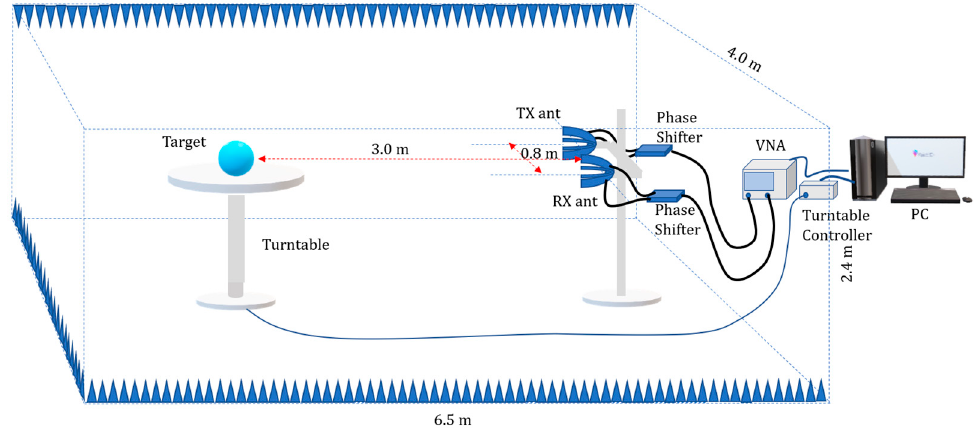
Figure 1. The measurement plan. The pyramidal absorbers shall be placed evenly at the inner sides of all six chamber’s walls. all six chamber’s